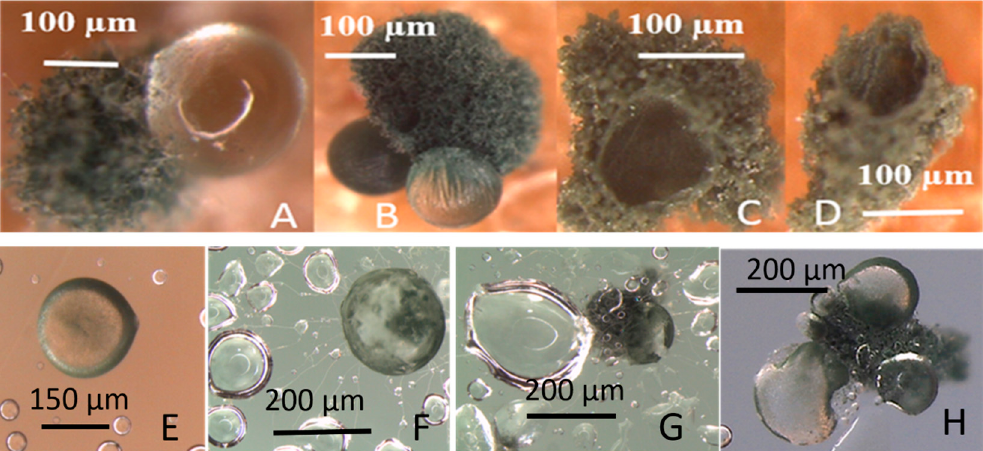
Figure 10. Stereomicrographs of Trichoderma atroviride 14/AM colonies grown for 3 weeks on a gypsum liner in a sealed Petri plate with the lid upwards. The upper row shows colonies with large guttation droplets ( A , B ) and dry empty membrane structures ( C , D ) growing on the gypsum liner. The lower row shows guttation droplets containing conidia on the inner surface of the lid. Panel ( E ) shows a fresh droplet, Panels ( F , G ) show droplets where conidia germinated, and hyphae extrude from the droplet. Panel ( H ) shows a new colony producing guttation droplets on the inner surface of the